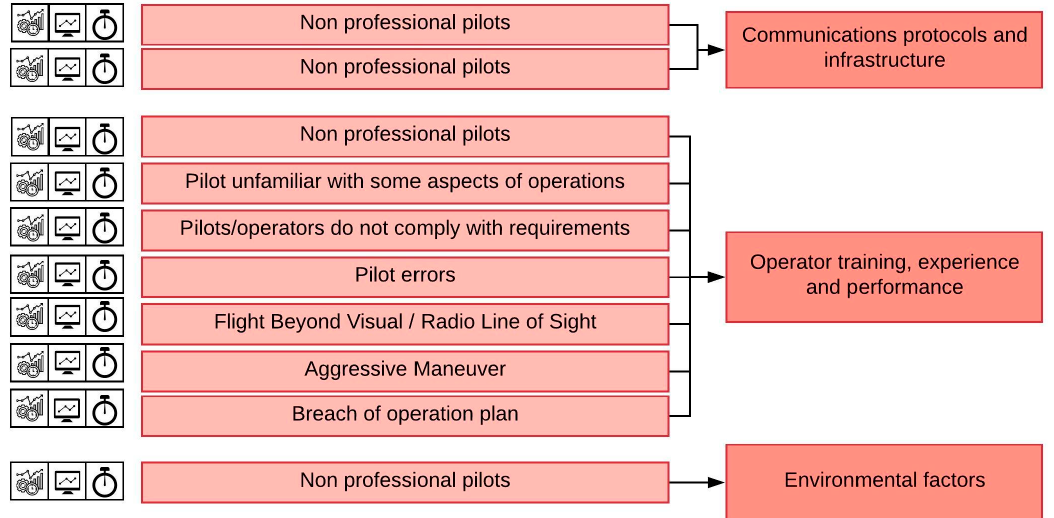
Figure 5. Hazards not covered by current U-space services.